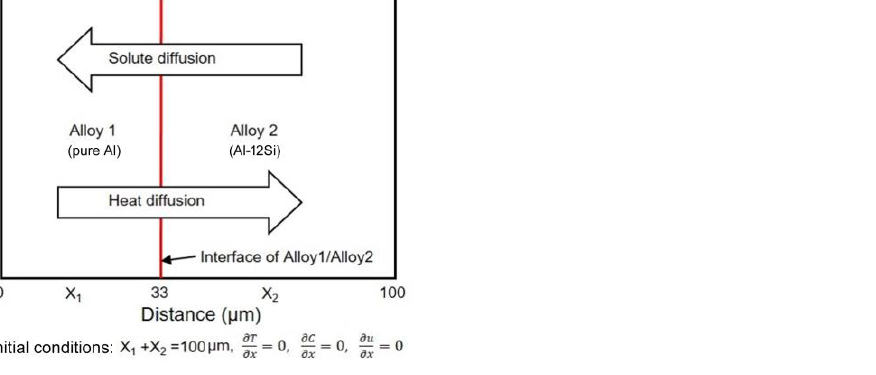
Figure 2. Schematic diagram of the model for revealing the interface conditions of pure Al/Al- 12